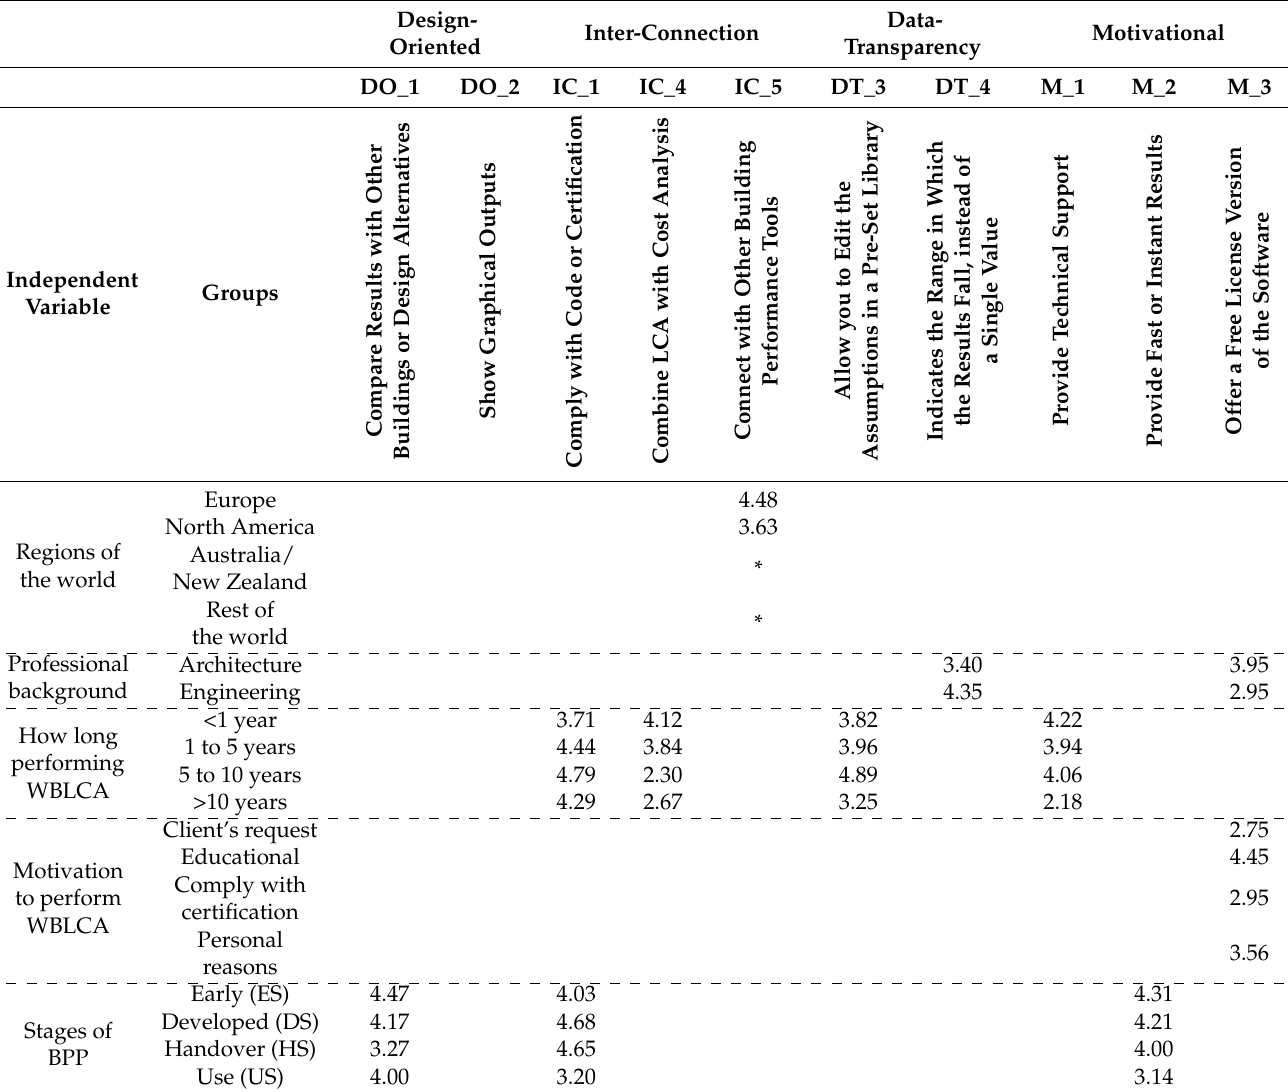
Table 7. Rating means of the software attributes’ usefulness within different groups. Design- Inter-Connection Oriented